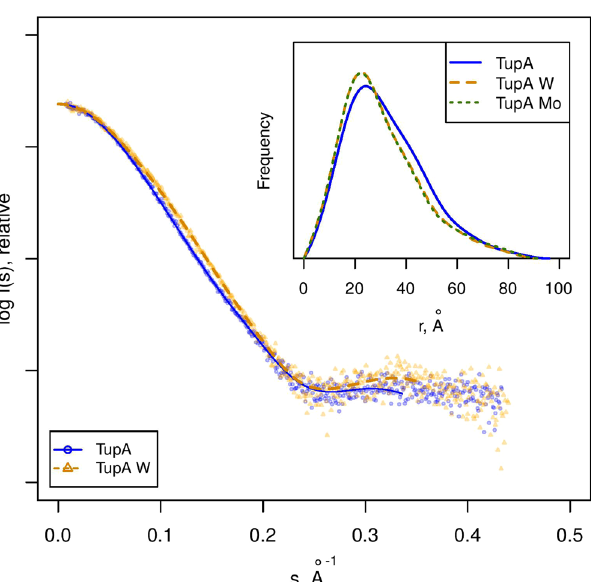
Figure 3. SAXS scattering data (points) and GNOM fits (lines) for TupA in the absence (TupA) and presence of tungstate (TupA W). The data collected in presence of molybdate was omitted from the main plot for clarity as it matches the TupA W data up to noise. Insert: distance distribution functions ( P ( r )) for the different conditions